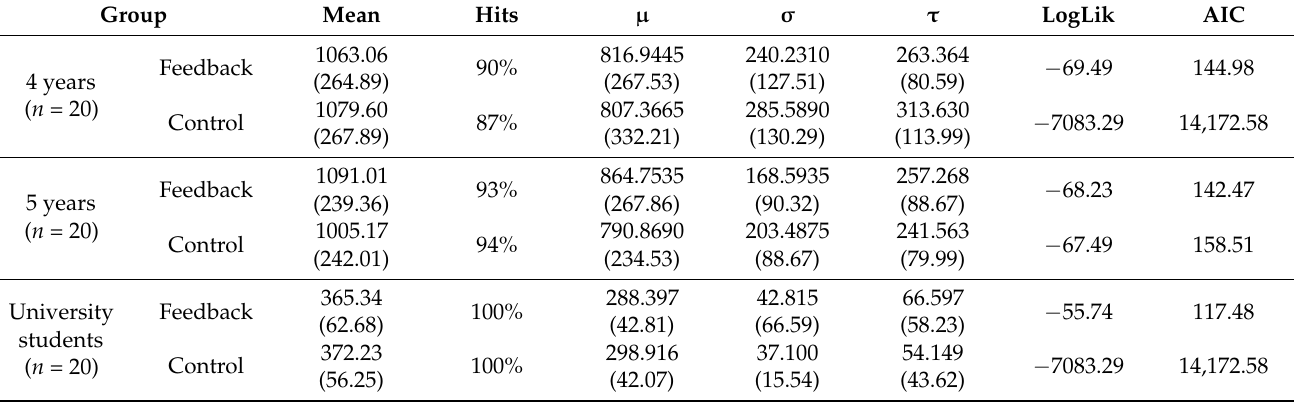
Table 1. Descriptive statistics for the feedback block and groups of age and reaction time parameters. Standard deviation in brackets.